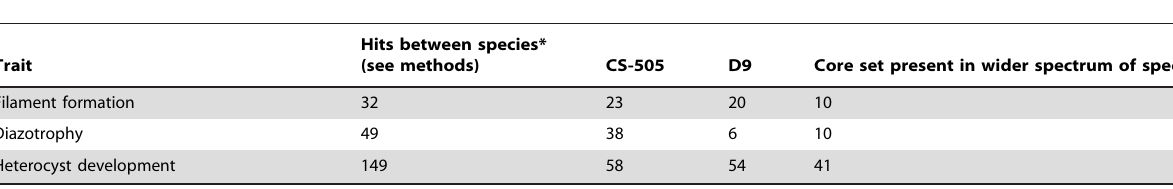
Table 3. Common genes for the different traits.